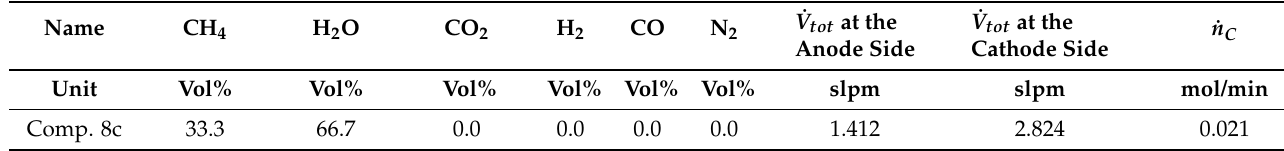
Table 4. Inlet gas compositions for the second long-term single cell tests.